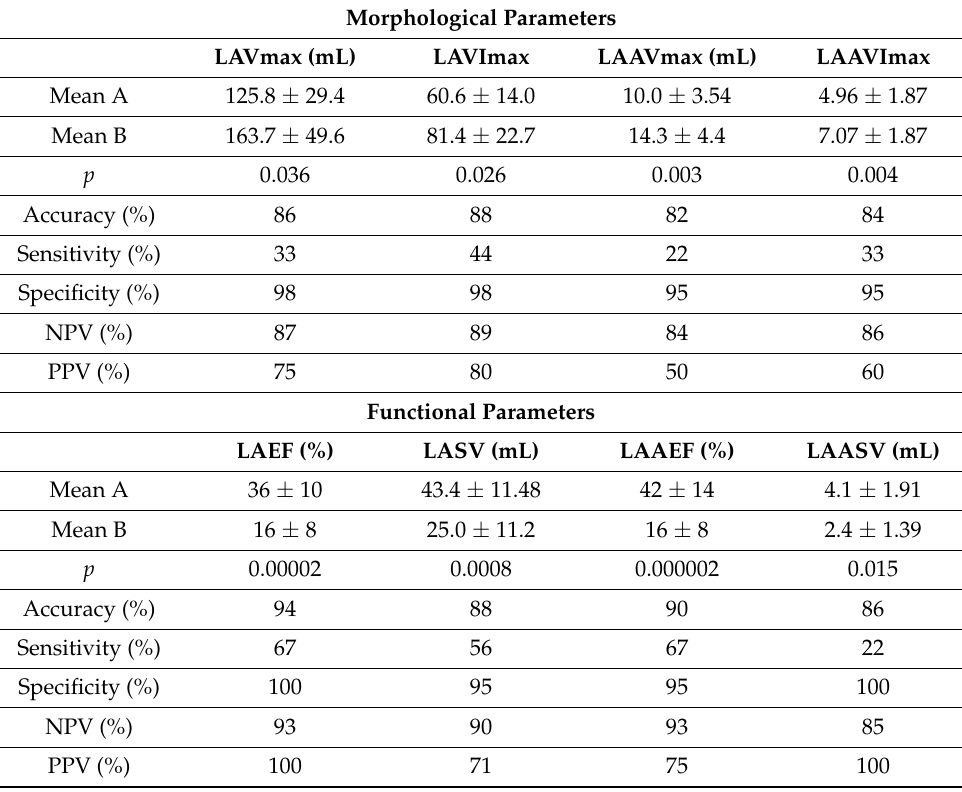
Figure 2. Logistic regression model for risk of recurrence (%) with left atrial ejection fraction (LAEF) (%) to left atrial volume (LAVmax) (mL) as outcome predictors. For example, a patient with an LAEF of 40% and LAVmax of 100 mL had a risk of recurrence of less than 10% (dark green area). However, a patient with lower values of LAEF, e.g., 10%, and the same value of LAVmax of 100 mL had a high risk of recurrence (>80%). The figure also illustrates that LAEF had more predictive power than LAVmax in this study population. Table 2. Measurements and performance analysis of morphological and functional cardiac computed tomography (CT) parameters (group A: non ‐ recurrence, group B: AF recurrence, NPV = negative predictive value, PPV = positive predictive value).